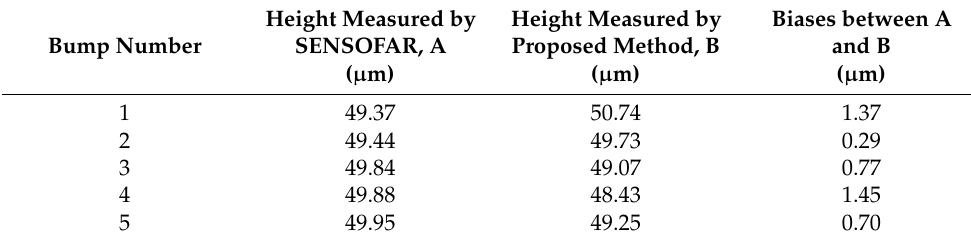
Table 1. Comparison of measurement results of proposed method with SENSOFAR instrument.